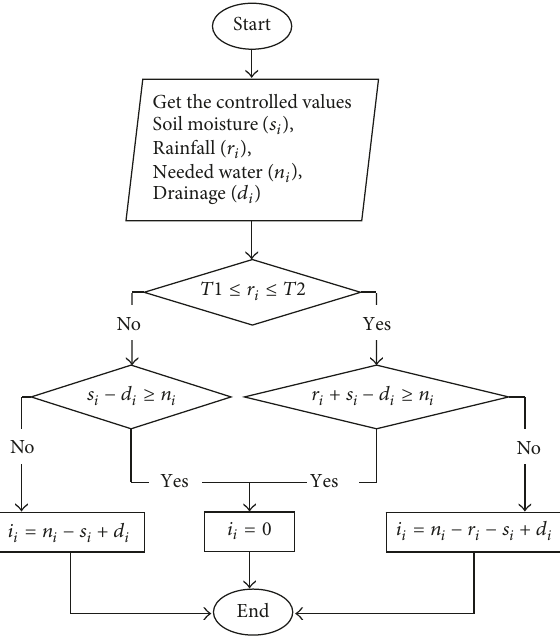
Figure 3: Flow chart of the proposed